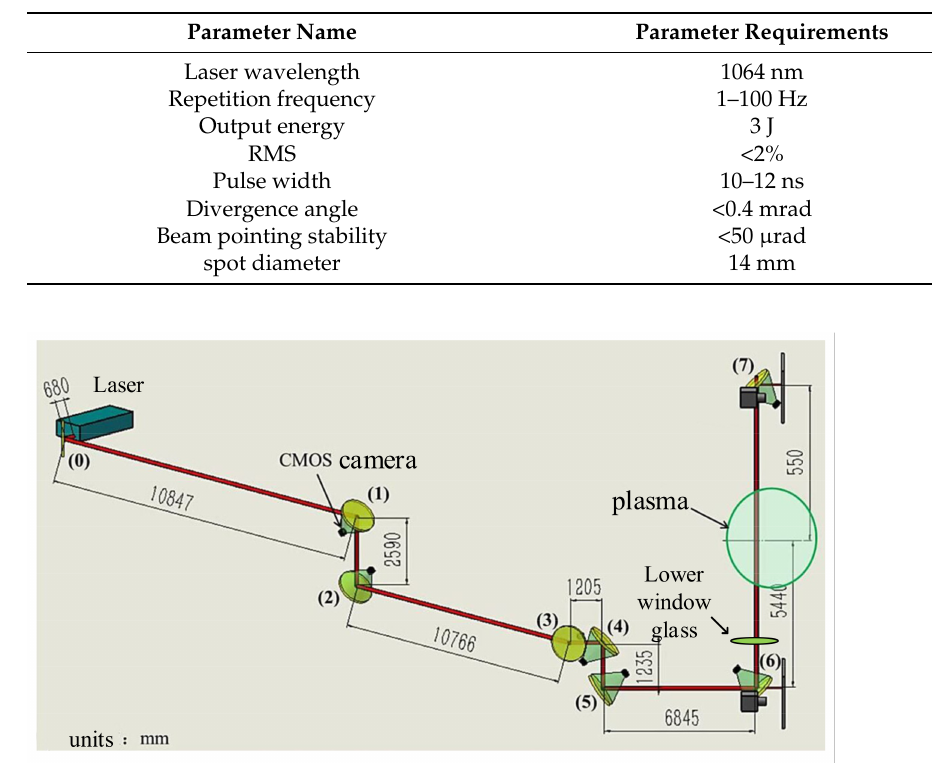
Table 1. Nd: YAG laser technical index